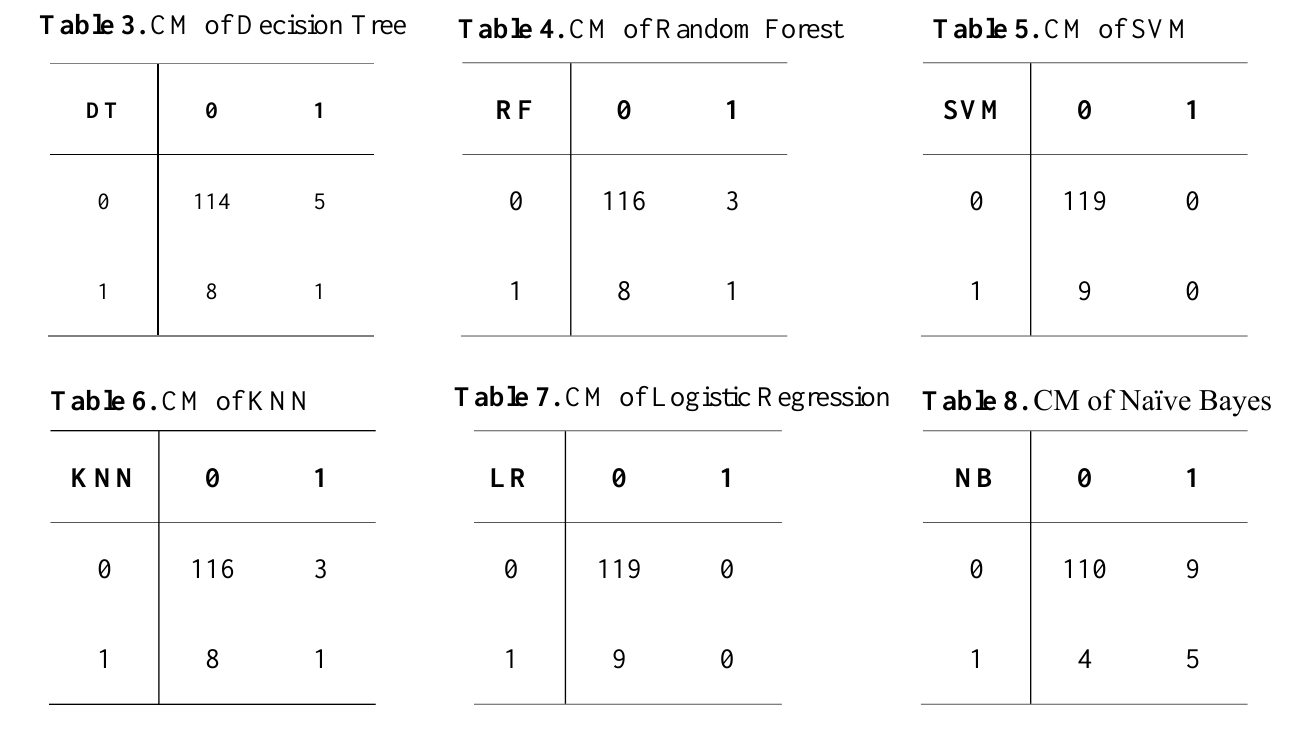
Table 3. CM of Decision Tree Table 4. CM of Random Forest Table 5. CM of SVM